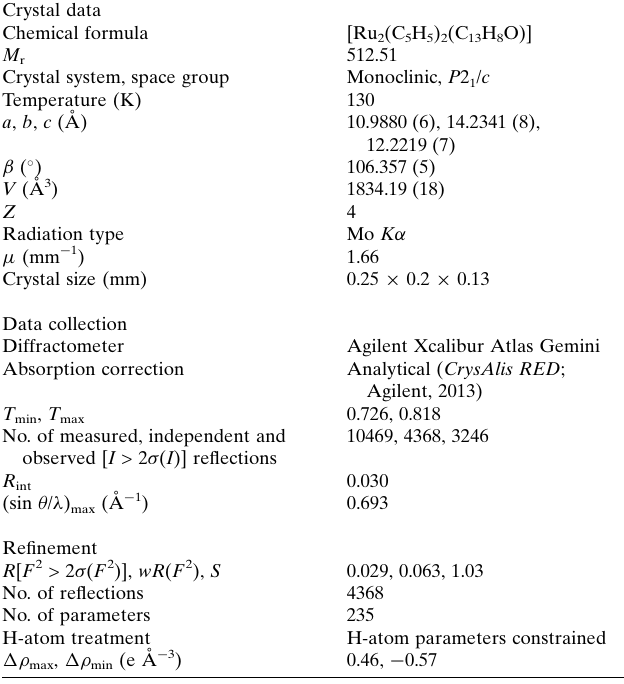
Table 1 Experimental details. Crystal data Chemical formula